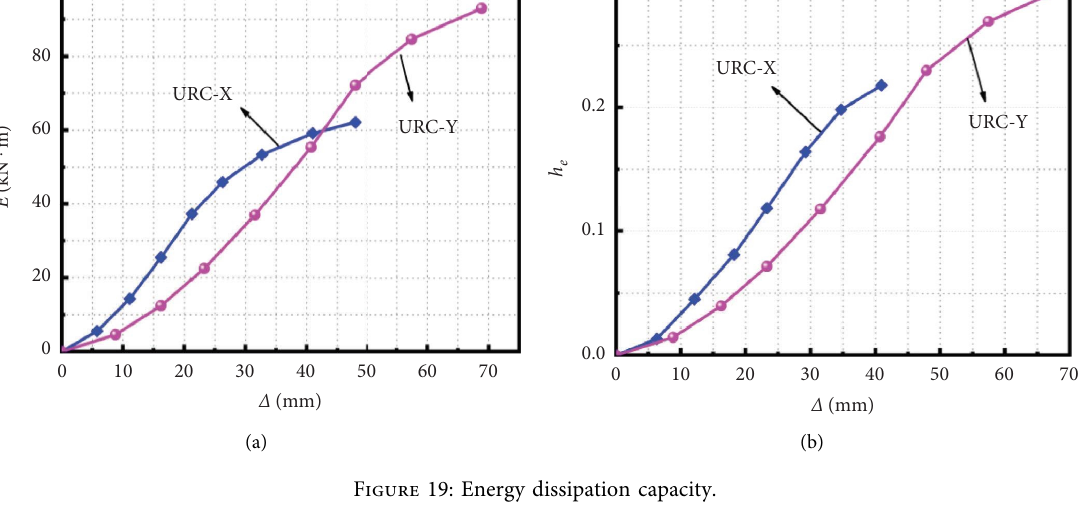
Figure 19: Energy dissipation capacity.